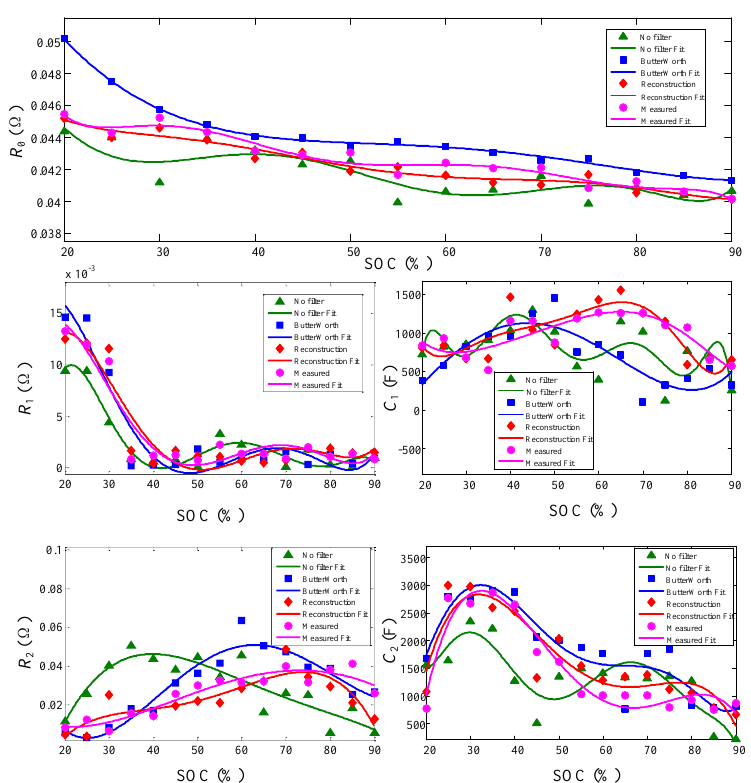
Figure 8. Model parameter variations with different methods at 25 ◦ C.